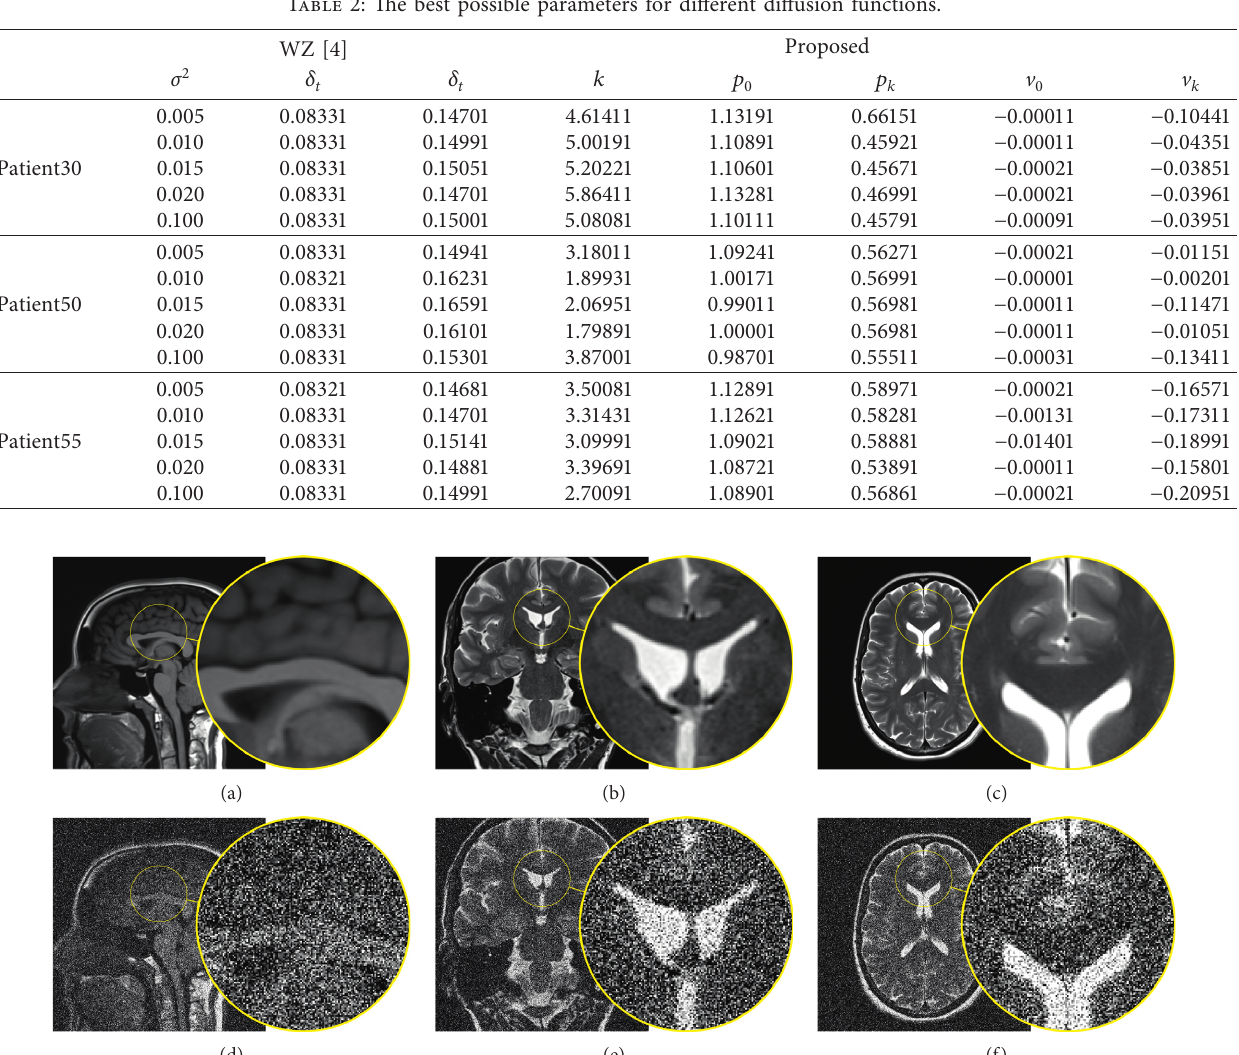
Table 2: The best possible parameters for different diffusion